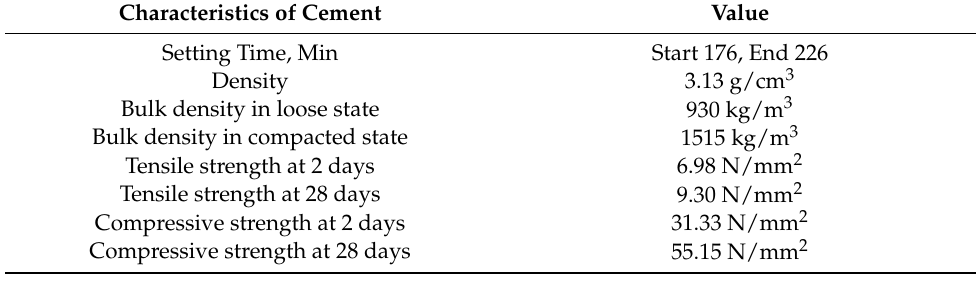
Table 1. Physical–mechanical characteristics of cement.